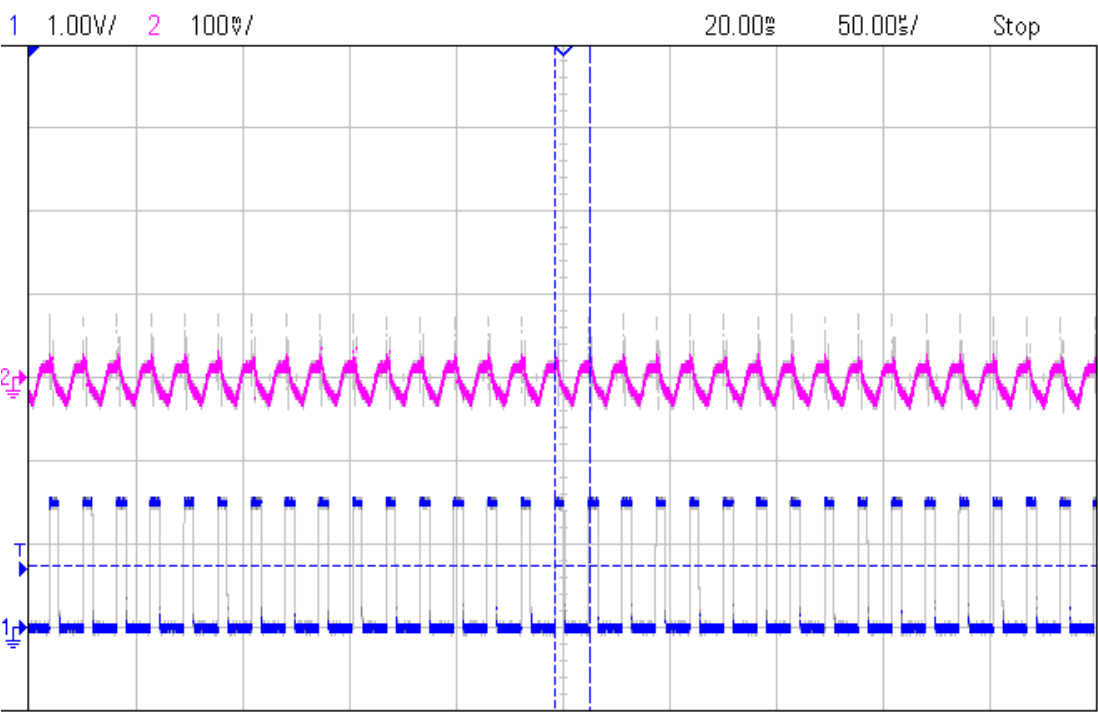
Figure 14. Output voltage ripple (upper plot) and PWM (bottom plot) for PI closed-loop operation, with 𝑒 (cid:2870) = 0 V.